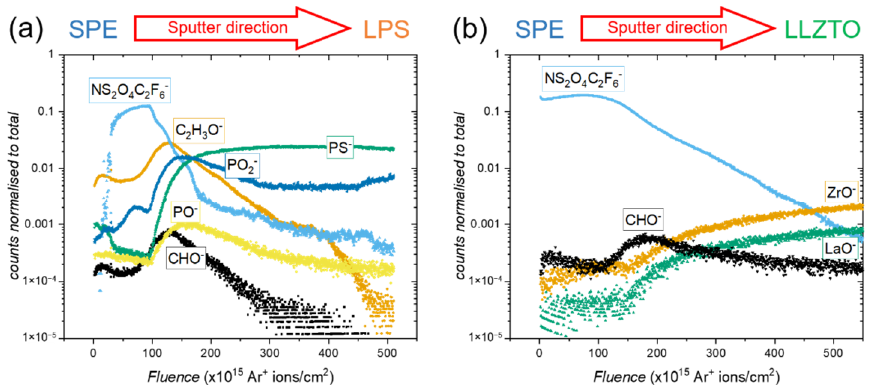
Figure 3. Depth-profiled ToF-SIMS of: ( a ) the PEO 10 :LiTFSI/LPS interface; and ( b ) the PEO 10 :LiTFSI/LLZTO interface.